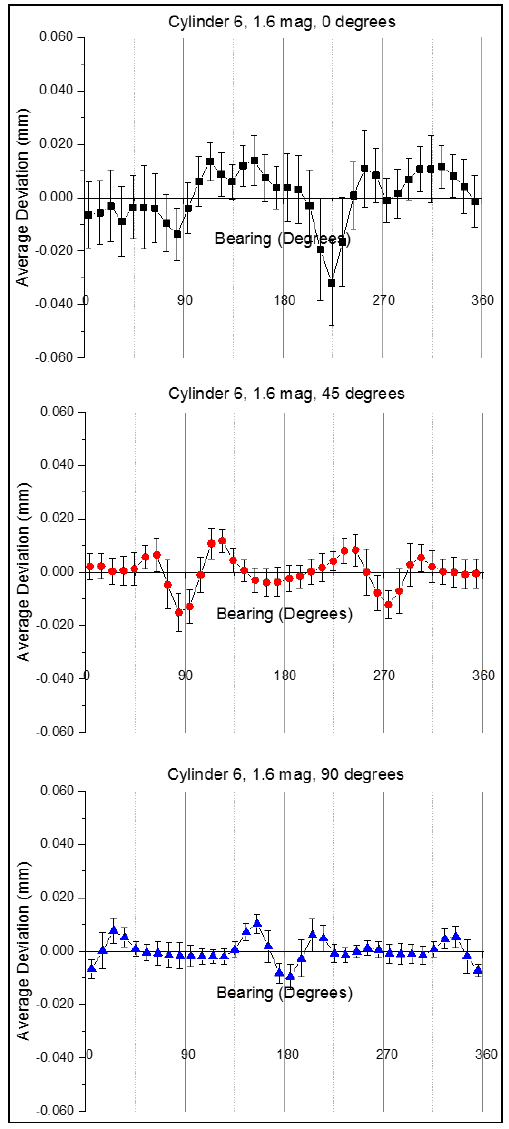
Figure 16: Average deviation, taken every 10 ⁰, of fit point of cylinder 6 to surface. Error bars are equal to the standard deviation.